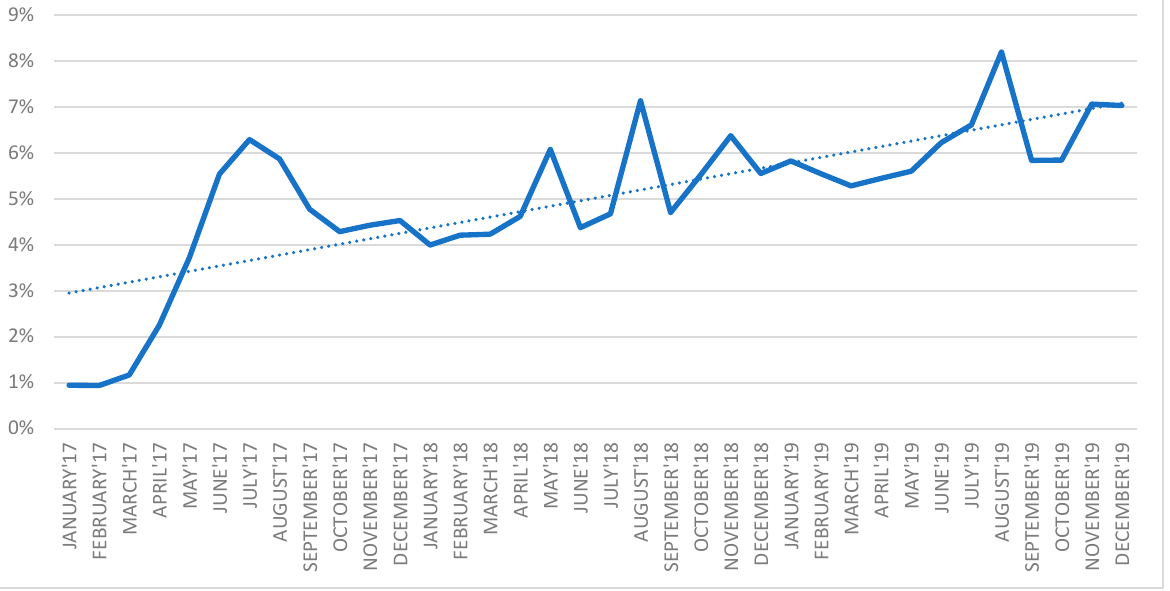
Figure 13. The ratio of prescription visits performed by nurses to all prescription visits.